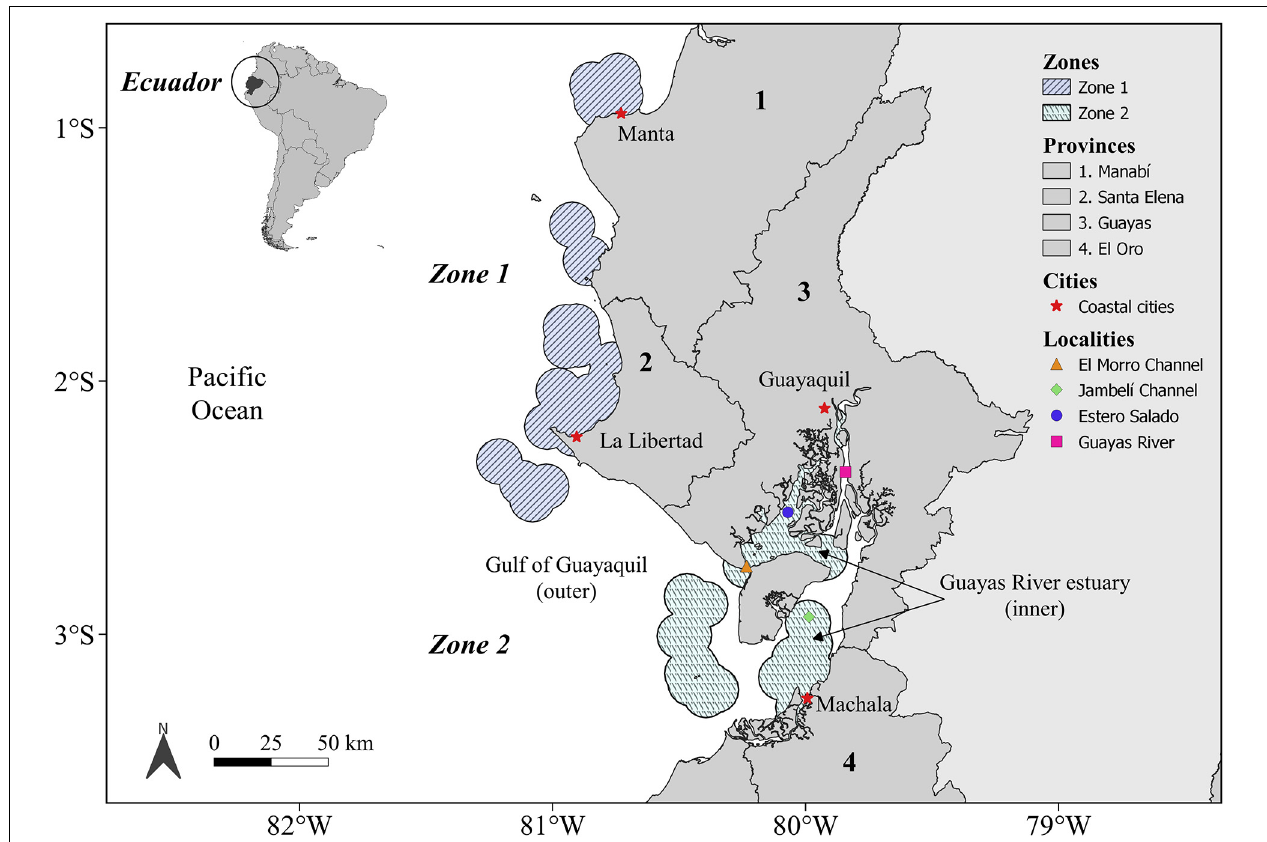
FIGURE 1 | Study area. Zone 1 is situated between the coastal cities of Manta and La Libertad; Zone 2 is located around the outer and inner (Estero Salado and Jambelí Channel) Gulf of Guayaquil